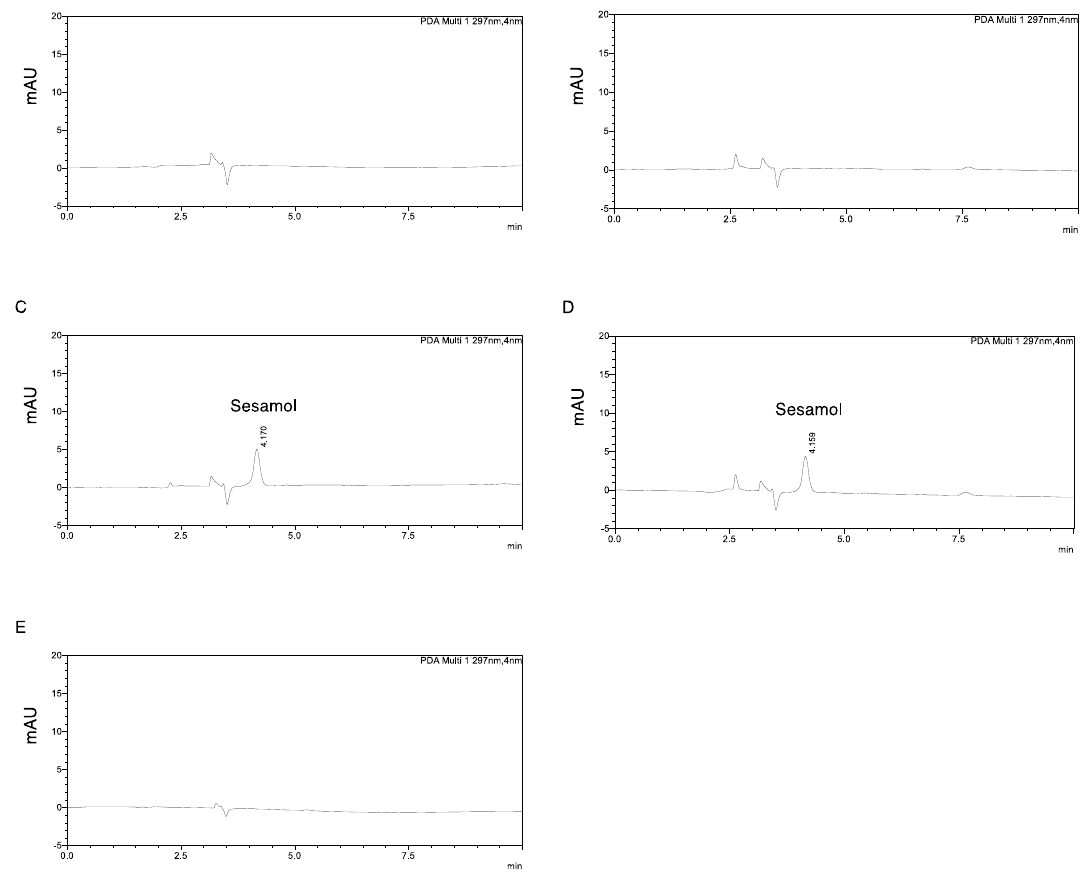
Figure 2. HPLC chromatograms of analytes detected at 297 nm. ( A ) Methanol solvent, ( B ) prepared SK-MEL-2 cell lysate, ( C ) sesamol dissolved in methanol (final concentration of 900 ng/mL), and ( D ) SK-MEL-2 cell lysate spiked with sesamol (final concentration of 900 ng/mL). Additional peaks of sesamol in ( C ) and ( D ) appeared at retention times of 4.152 ± 0.008 min ( n = 10). ( E ) Carryover effect showed no leftover peak of sesamol after an injection of 900 ng/mL sesamol for 10 min followed by